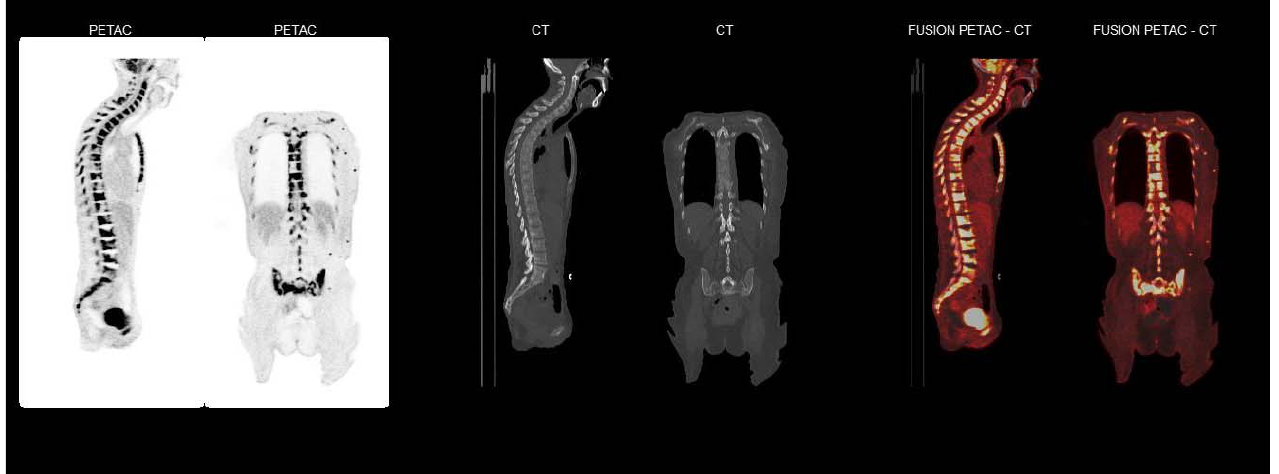
Figure 3. [ 18 F]FDG-PET/CT of the vertebral column/bone marrow. The pictures demonstrate extensive FDG ‐ uptake in the whole axial skeleton.